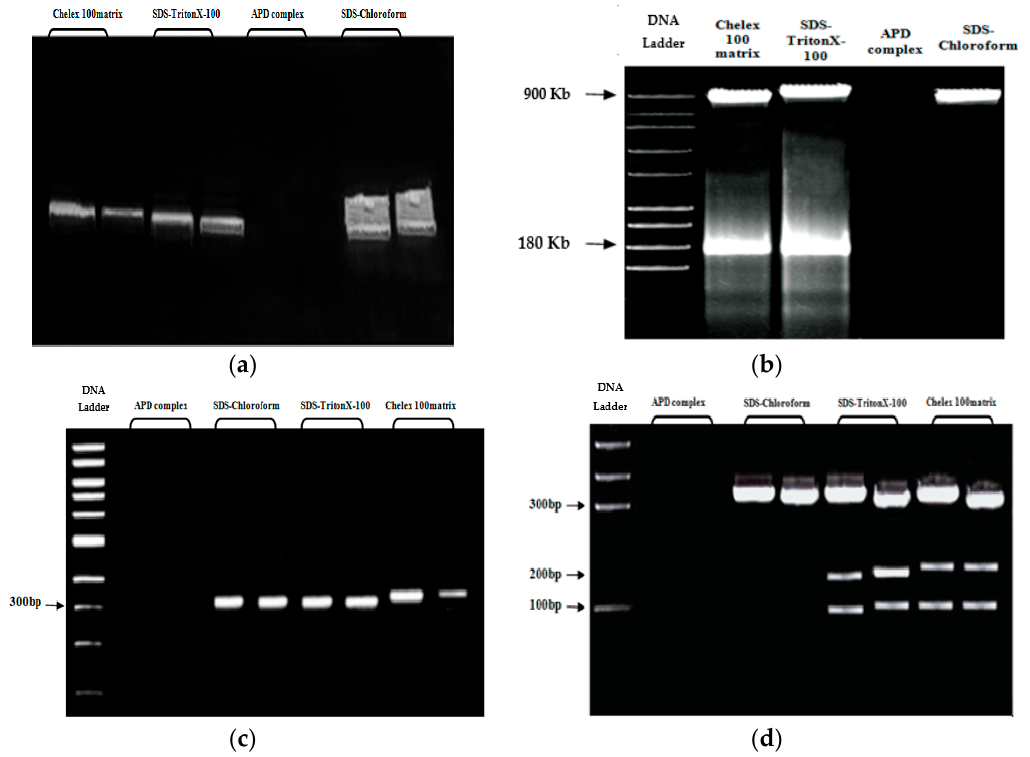
Figure 5. Electrophoretic analysis ( a ), pulsed-field gel electrophoresis (PFGE) analysis ( b ), electrophoresis analysis of the PCR product ( c ), and electrophoresis analysis of the polymerase chain reaction (PCR) product after digestion with HindIll restriction enzyme ( d ) of DNA extracted from Tetrahymena pyriformis using various extraction methods.